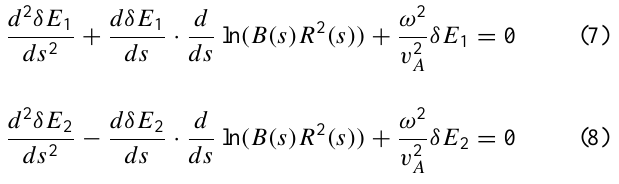
Fig. 4. Periods of the two Alfv·en wave modes along noon-midnight line. Positive X is towards the Sun.